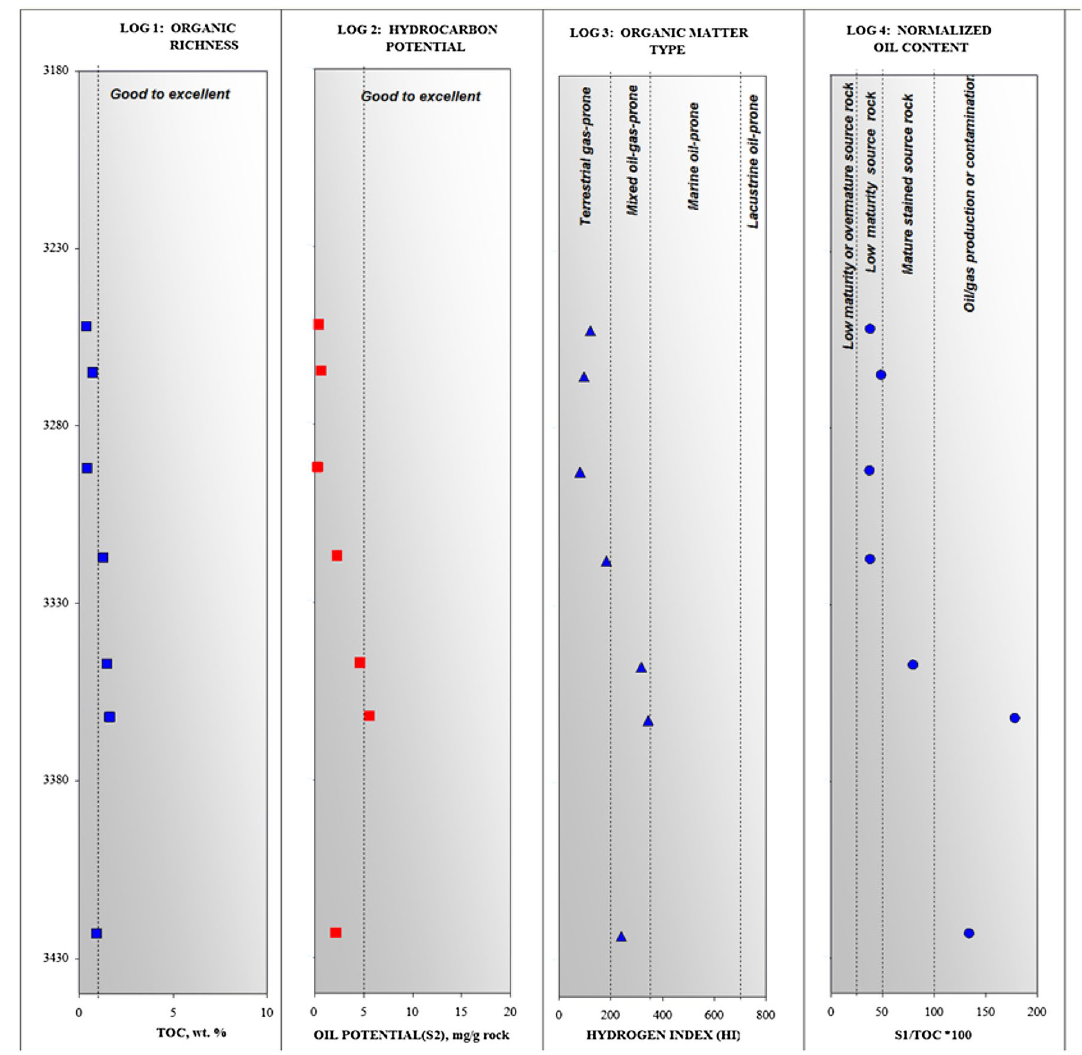
Fig. 11 Geochemical log for Chia Gara Formation in well Aj-12. The depth 3300-3380 m is relatively organic richness and shows a good hydro- carbon